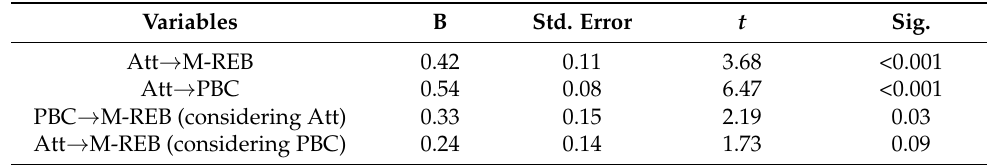
Table 6. Hypothesis test based on regression results.